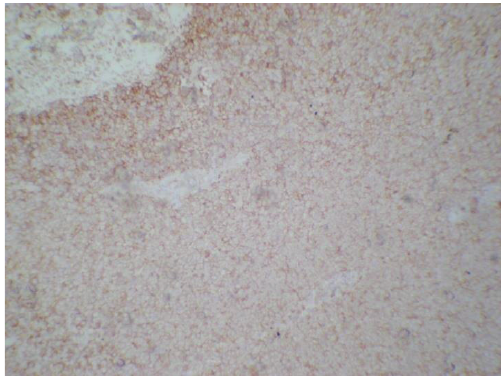
Figure 8: IHC revealed, tumor cells express Mic-2 with crisp cytoplasmic